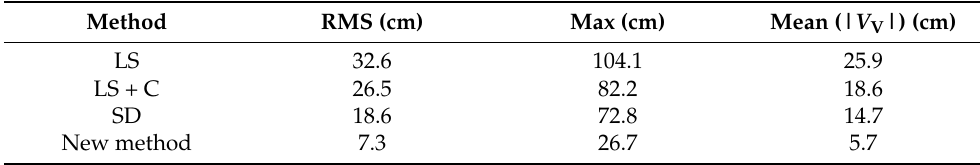
Table 2. The residuals statistics of all methods for vertical